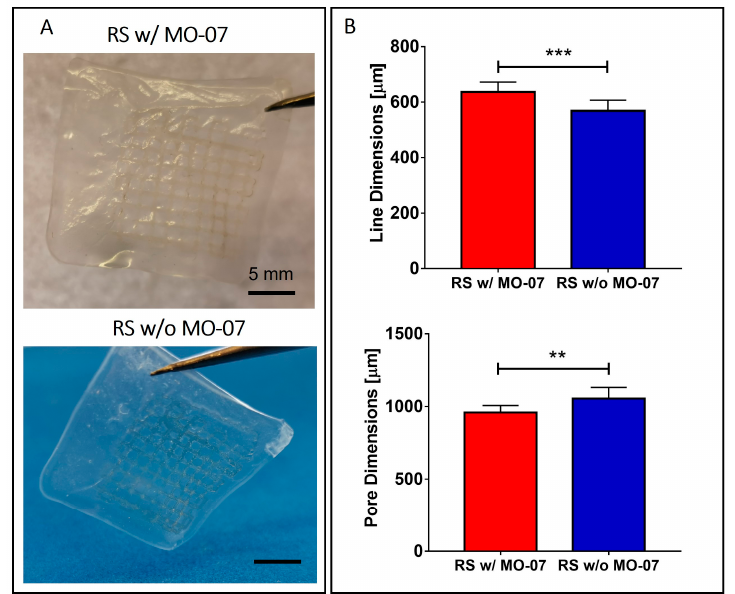
Figure 1. ( A ) Photos of the 3D-printed multilayered grids still on the Hydrofilm layer. ( B ) Morphological characterization of the grid. When the RS solution with MO-07 was used, a statistically significant increase in the line dimensions and a consequent reduction of the pore dimension was achieved. ** p ≤ 0.01 and *** p ≤ 0.001.